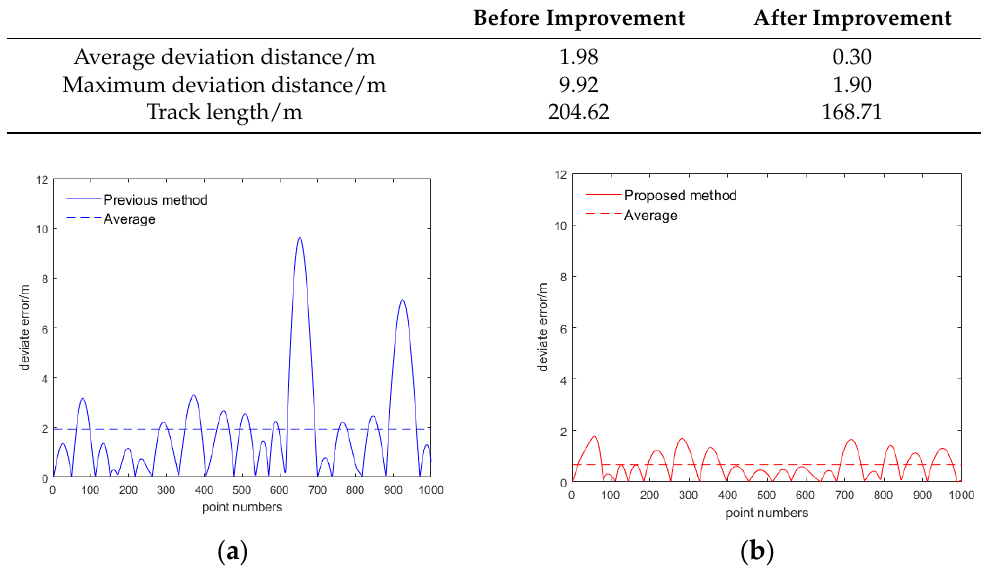
Table 3. Comparative experiments results.